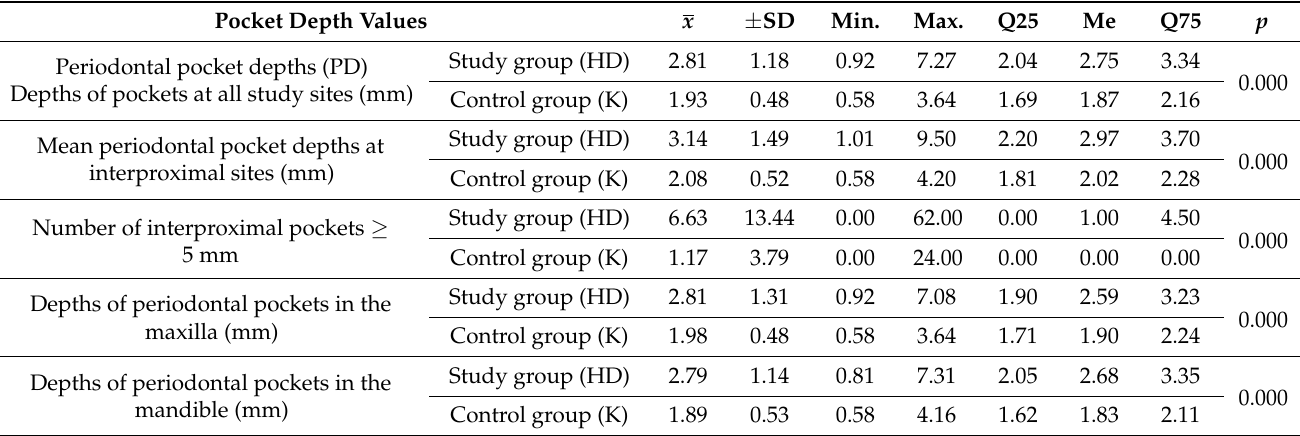
Table 3. Mean periodontal pocket (PD) depths and mean number of PD interproximal pockets ≥ 5 mm in the study groups (HD, K).